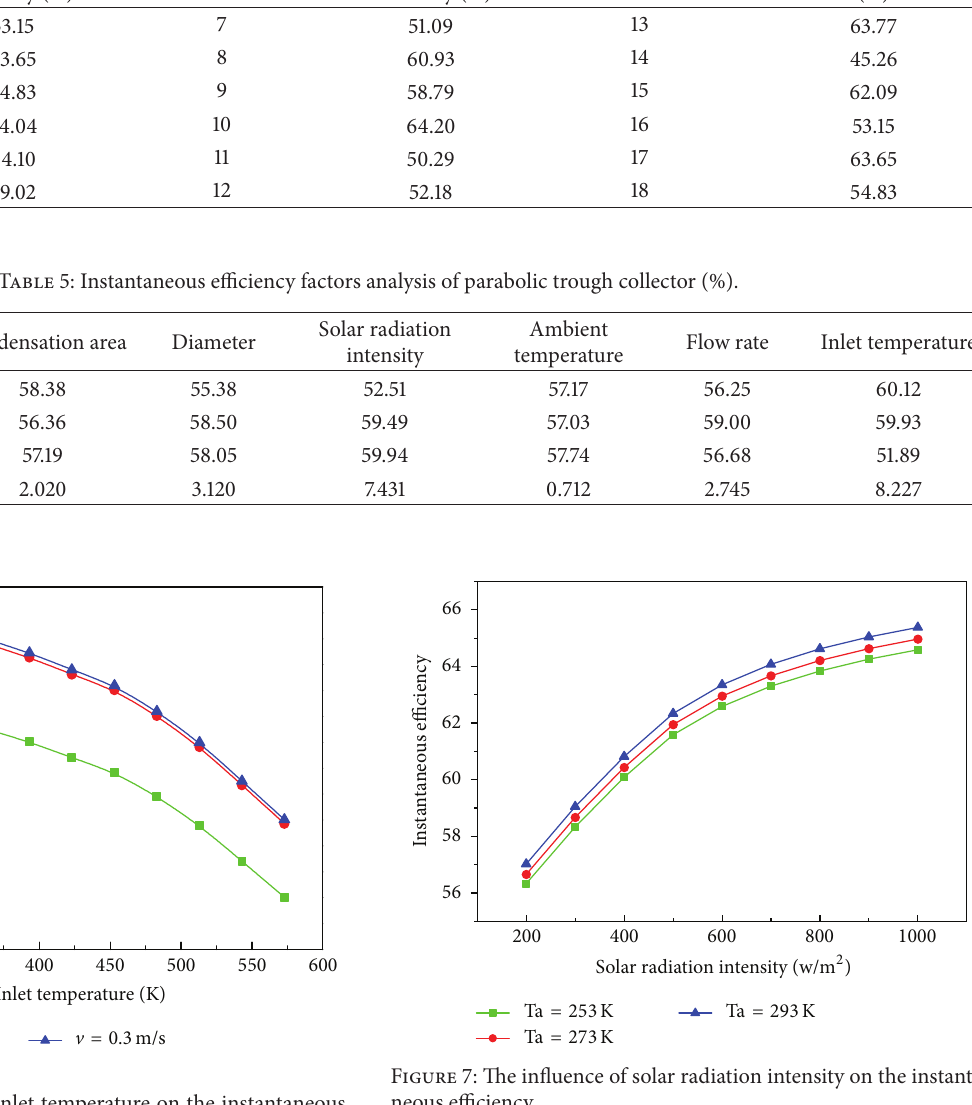
Figure 6: The influence of inlet temperature on the instantaneous efficiency.